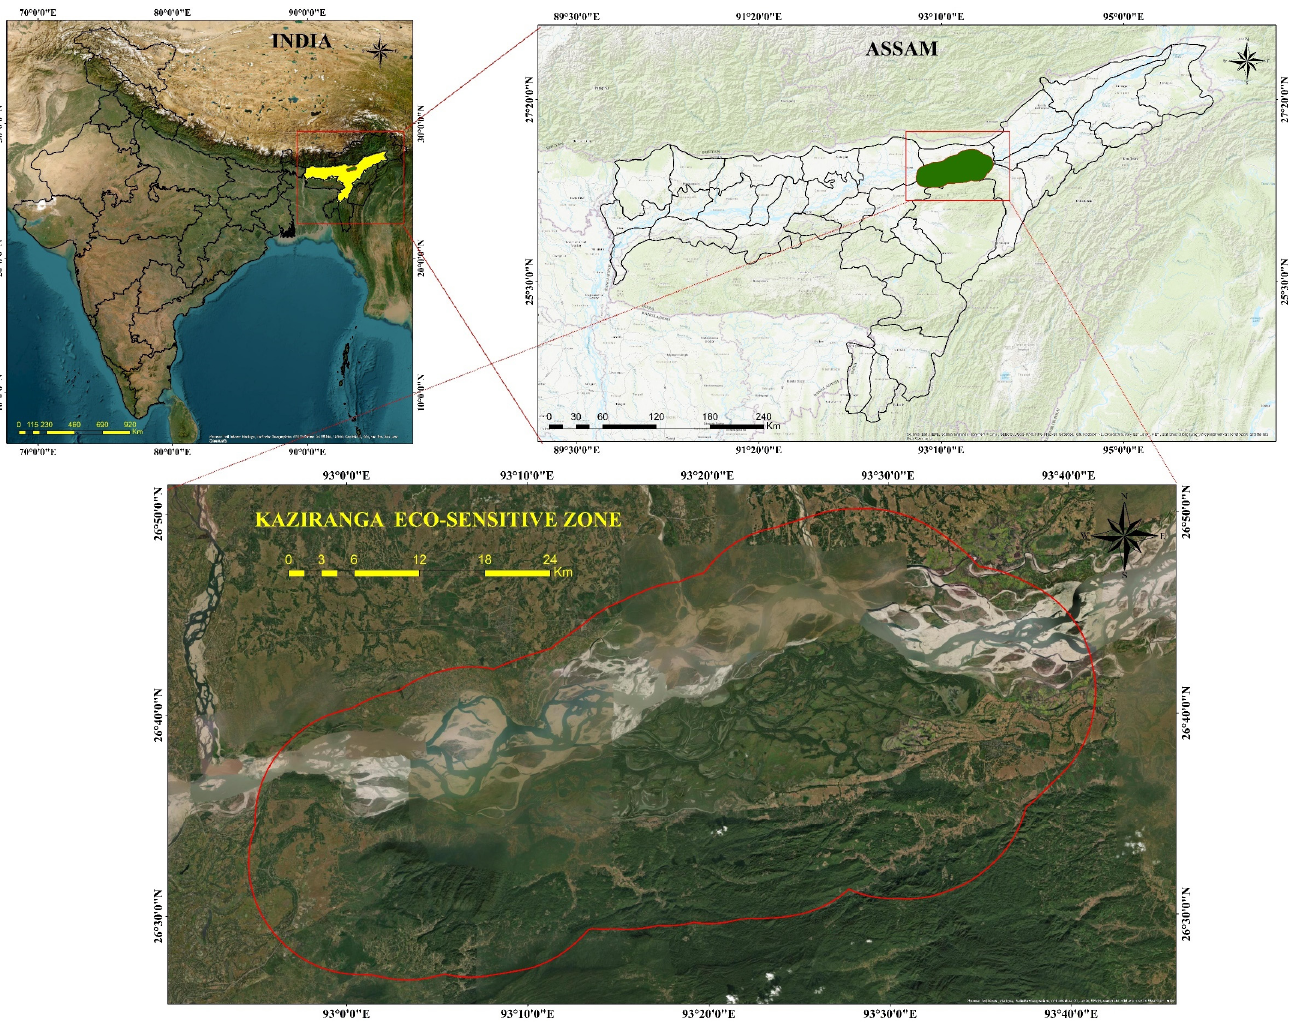
Figure 1. Location map of the Kaziranga Eco-Sensitive Zone.